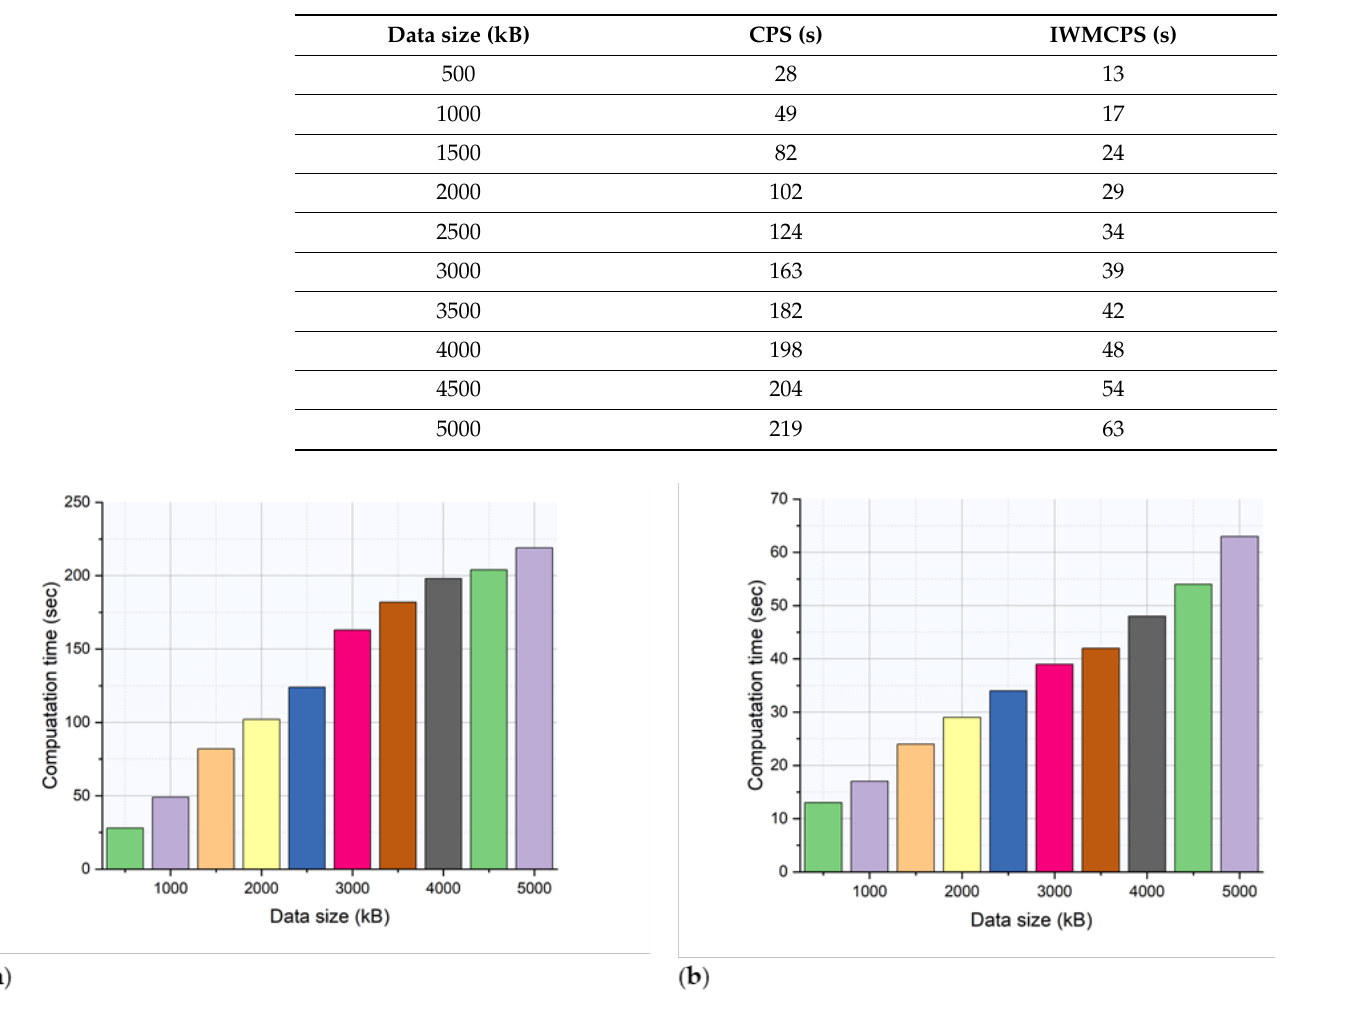
Figure 7. ( a ) Computation time analysis of the existing CPS model and ( b ) computation time analysis of the proposed IWMCPS model.